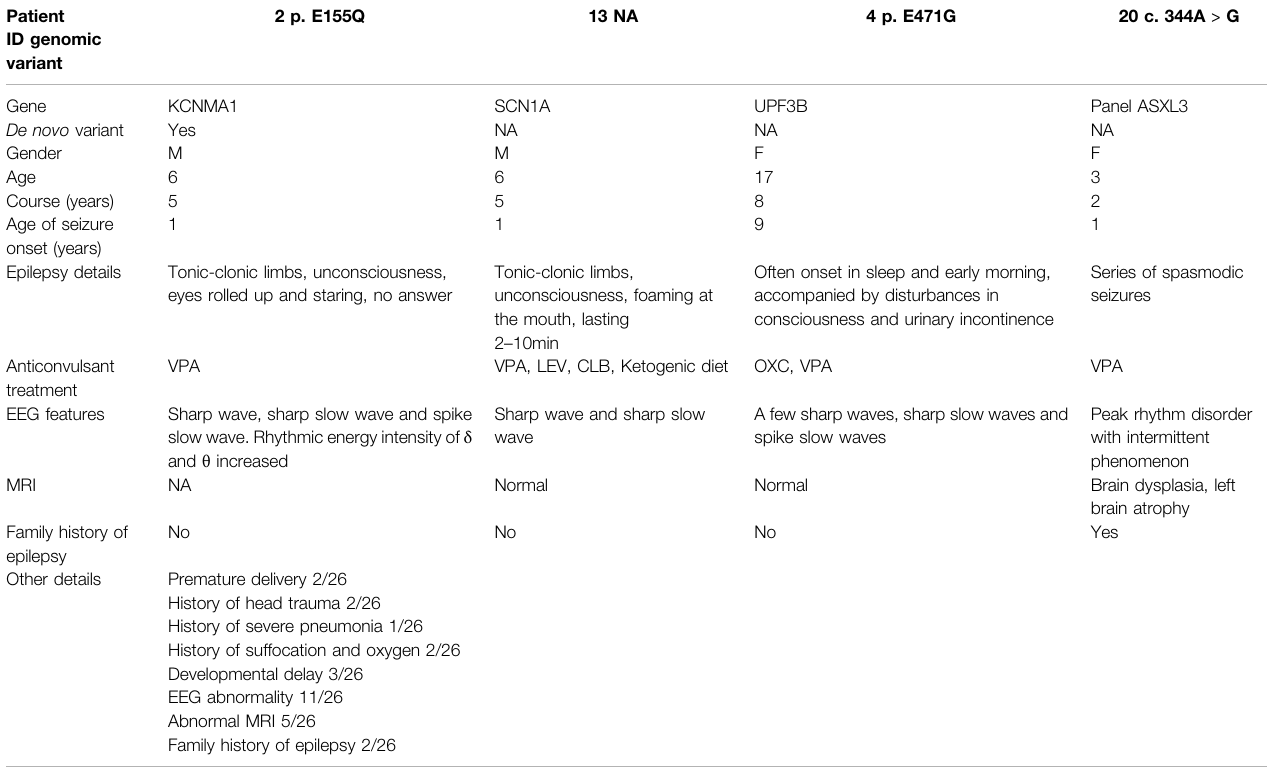
TABLE 1 | Clinical data of 26 patients with one LOF variants in BK